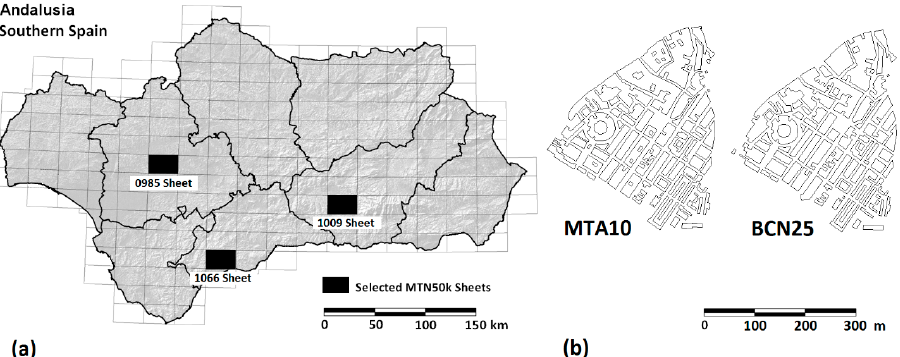
Figure 3. ( a ) Selected sheets of the Mapa Topográfico Nacional (MTN) at the scale of 1:50,000 of the region of Andalusia (southern Spain) and its administrative boundaries and ( b ) examples of polygonal features belonging to Mapa Topográfico de Andalucía E10K (MTA10) and Base Cartográfica Numérica E25k (BCN25) (Carmona, 0985